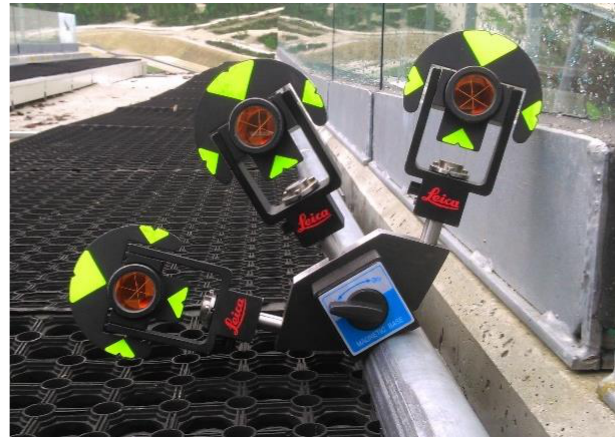
Figure 5. Setup of the new multi-prism platform on a tube.